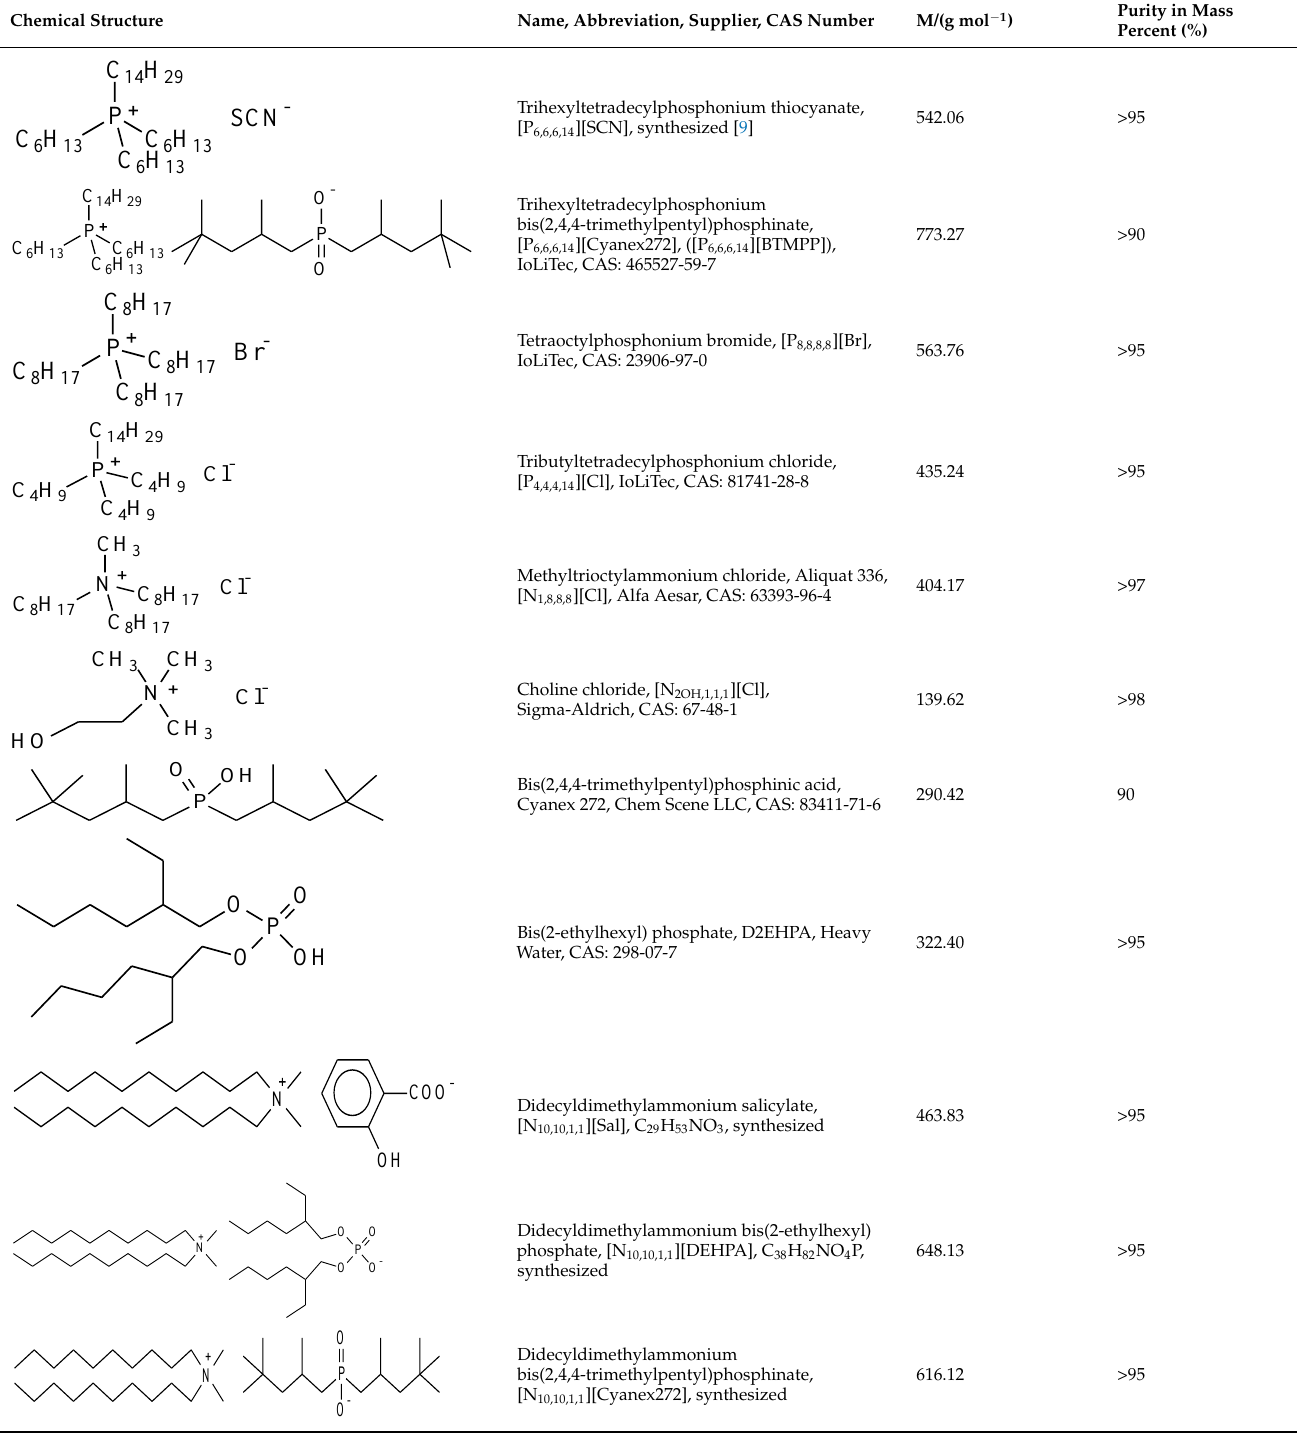
Table 5. Data on the ionic liquids used: structure, name, abbreviation of name, supplier, CAS number, molar mass (M), mass fraction purity (as stated by the supplier).